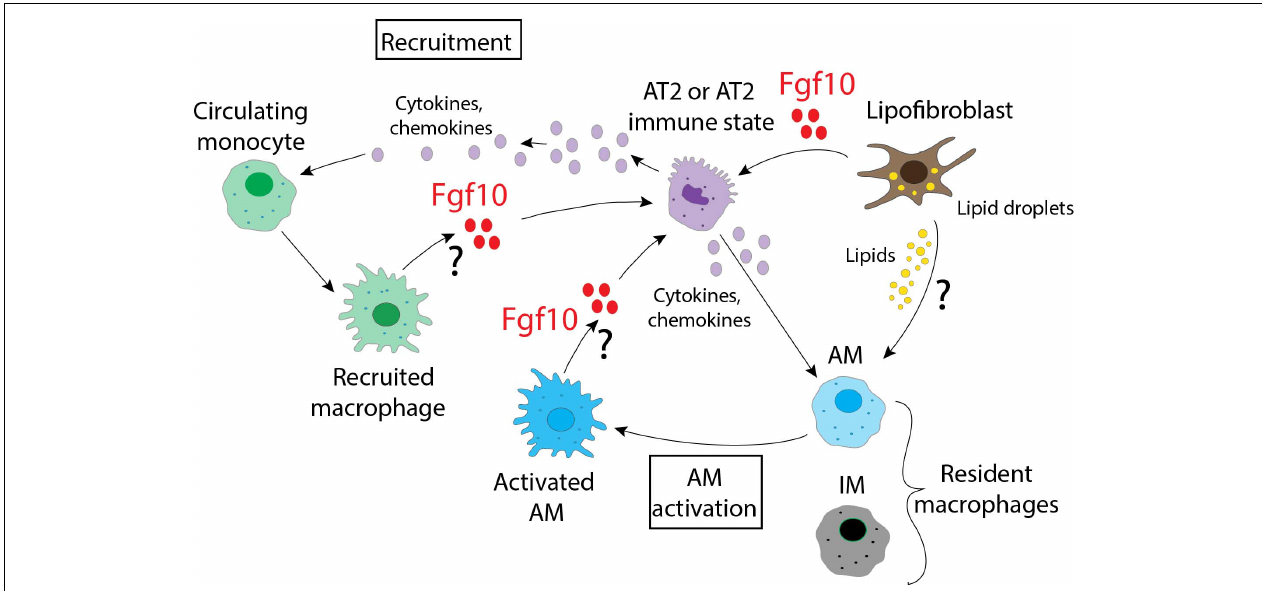
FIGURE 3 | A schematic representation of the possible interactions between different alveolar and immune cells in the lung. Fgf10, produced by lipofibroblasts, recruited macrophages and/or activated AMs, targets AT2 cells. Fgf10 can also orchestrate the production/release of chemokines and cytokines. Lipofibroblasts, via the secretion of lipids, can also activate the